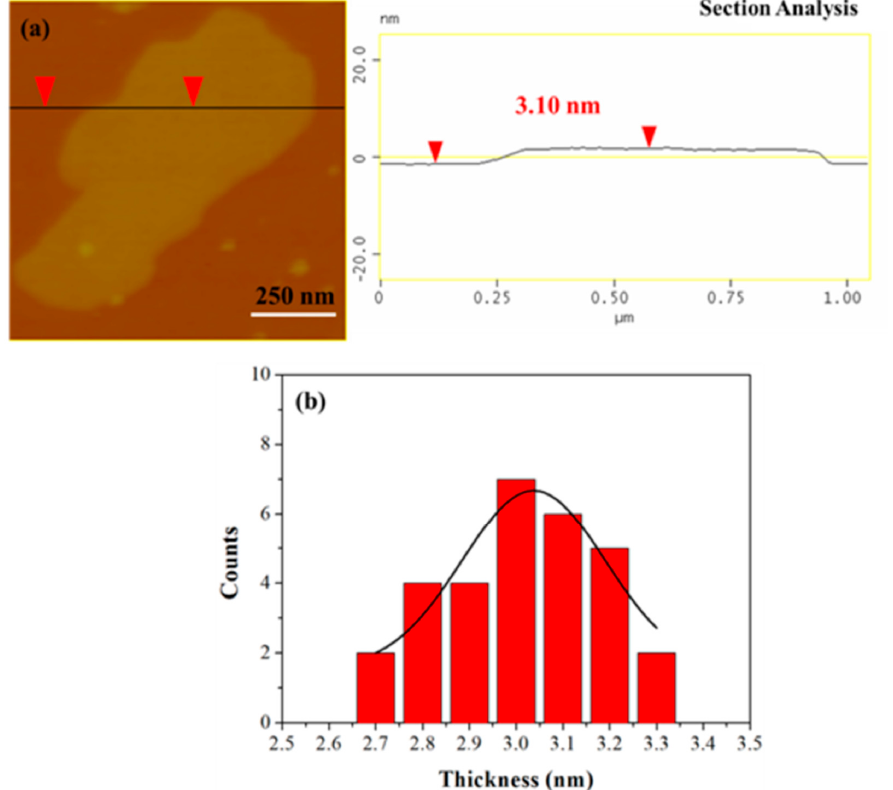
Figure 6. ( a ) AFM image of cross-sectional analysis of selected carbon nanosheet in PC sample, ( b ) AFM statistical analysis of thickness for 30 randomly selected nanosheets.